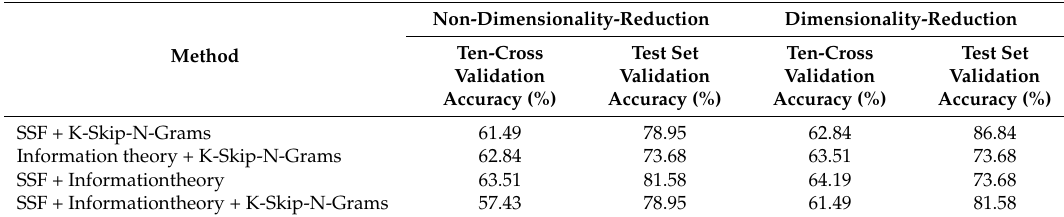
Table 5. PDB186 is classified by a random forest using mixed feature representations.